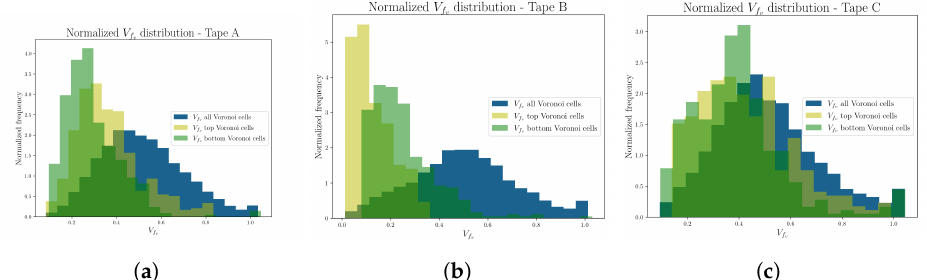
distributions based on several micrograph sections. Tape v